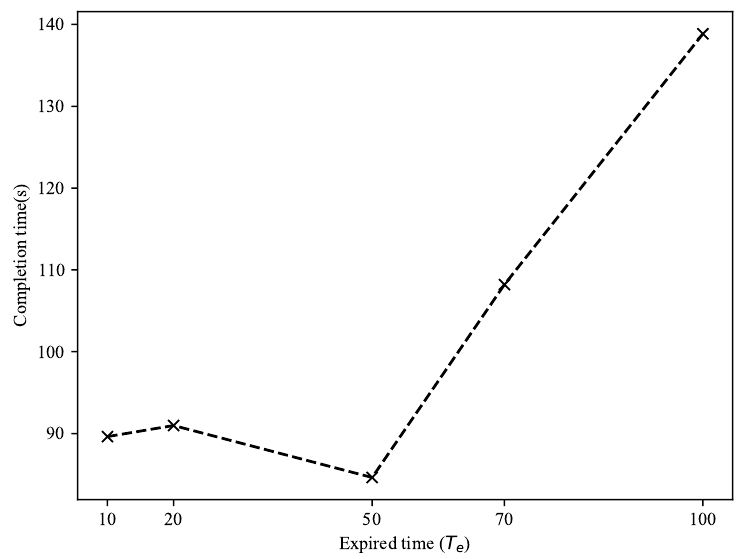
Figure 9. Completion time graph of the proposed method for expired time.